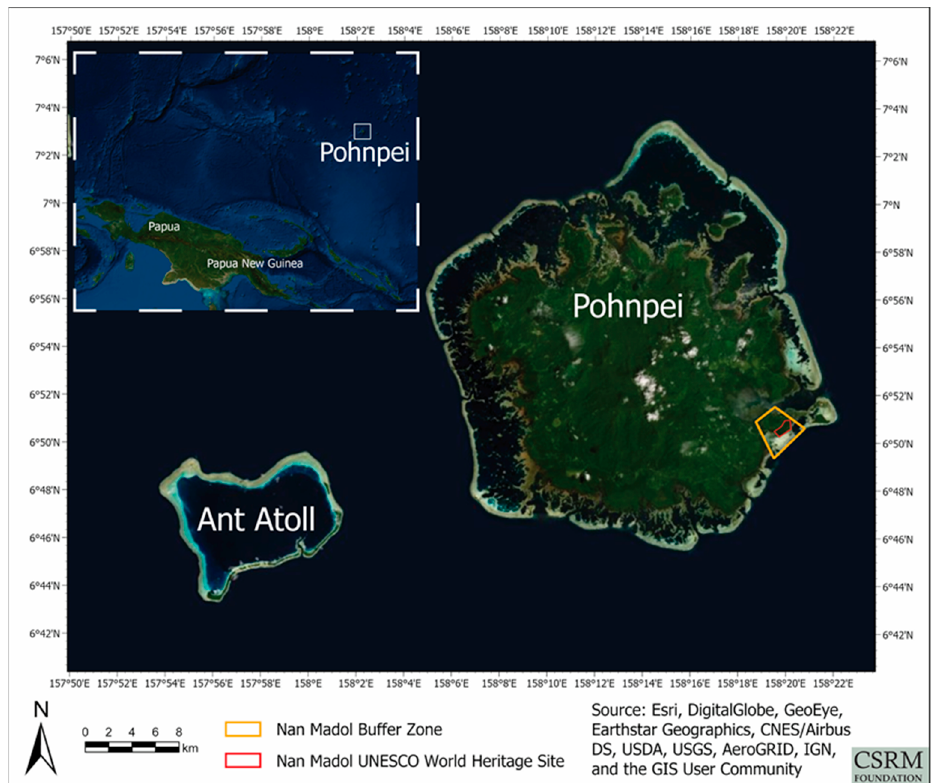
Figure 1. A regional map showing the location of the UNESCO World Heritage Site of Nan Madol and its buffer zone.